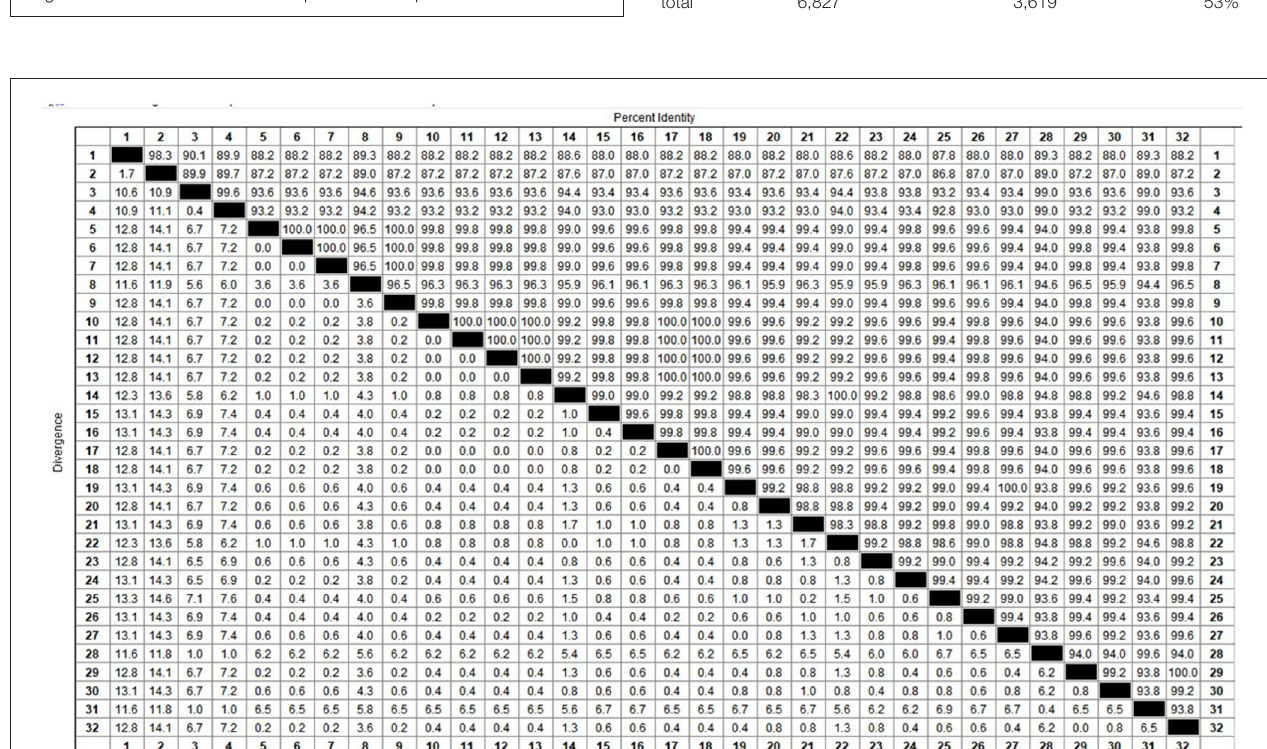
FIGURE 1 | PCR identification results of some positive samples. 1, DNA molecular size marker; 2–10, Partial positive samples; 11, Positive control; 12, Negative control. Arrow indicates the position of the predicted DNA size.